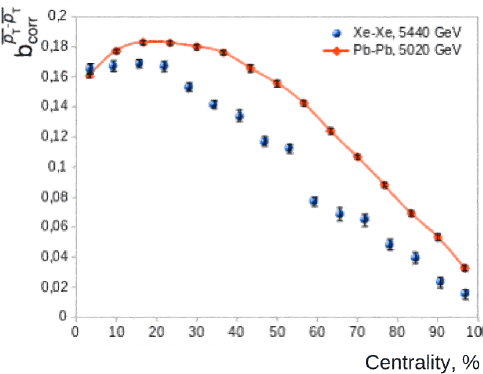
Figure 1. Mean transverse momentum correlation coe ffi cient as a function of centrality at LHC energy, calculated in the Monte Carlo model with string fusion for Pb-Pb and Xe-Xe